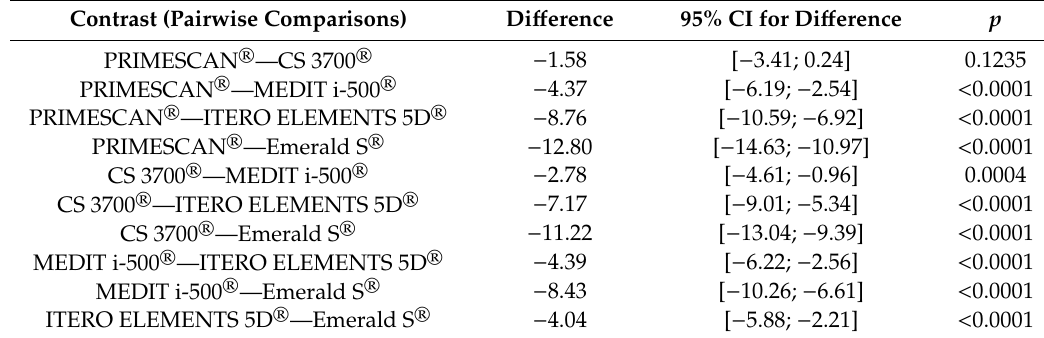
Table 3. Comparisons of mean absolute deviations between the